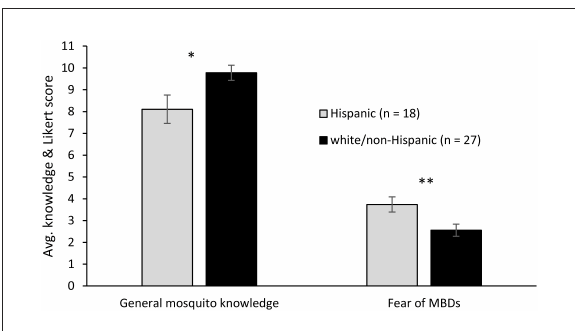
FIGURE2 Knowledge and attitudes showing significant differences between Hispanic and white/non-Hispanic respondents. The average knowledge score (y-axis) was calculated by averaging the total number of correct answers on general mosquito knowledge among respondents within each ethnic group. The average Likert score across all statements pertaining to the attitude fear of MBDs was calculated for each respondent, then averaged within ethnic group (y-axis). Individual t -tests were performed. * p < 0.05, ** p <